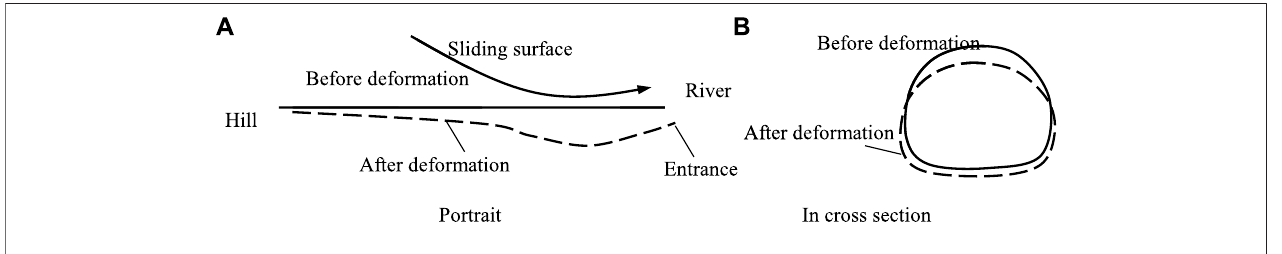
FIGURE 10 | Deformation diagram of the “ longitudinal pull ”